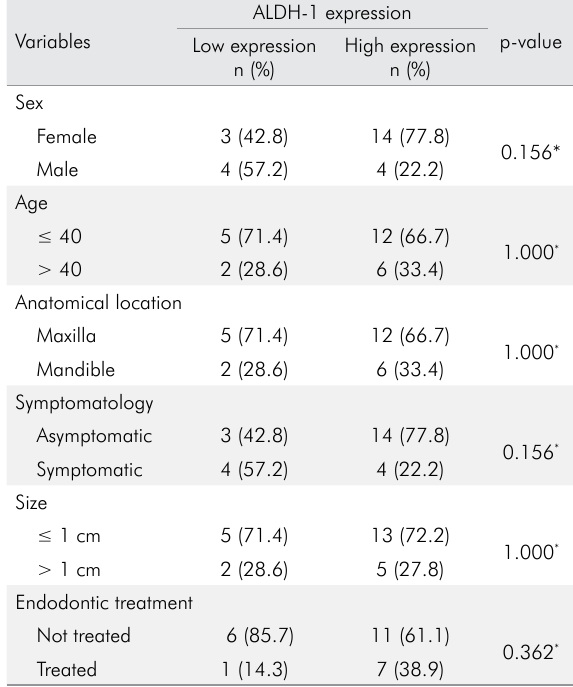
Table 3. Analysis of ALDH-1 expression in periapical